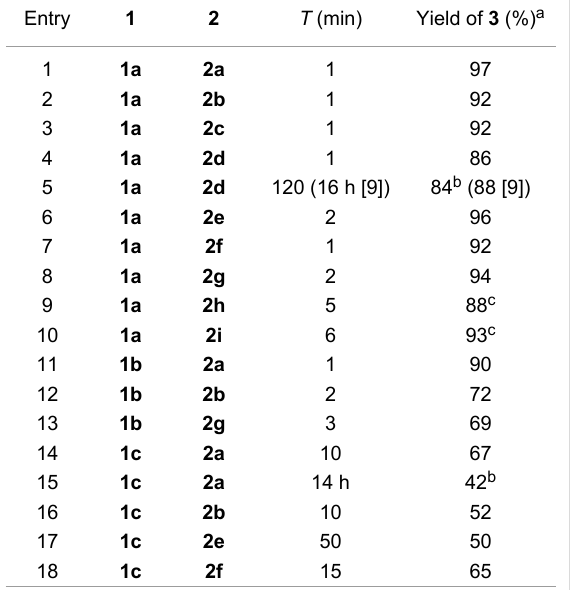
Table 2: Arylation of alkenes with arenediazonium tosylates in water under microwave